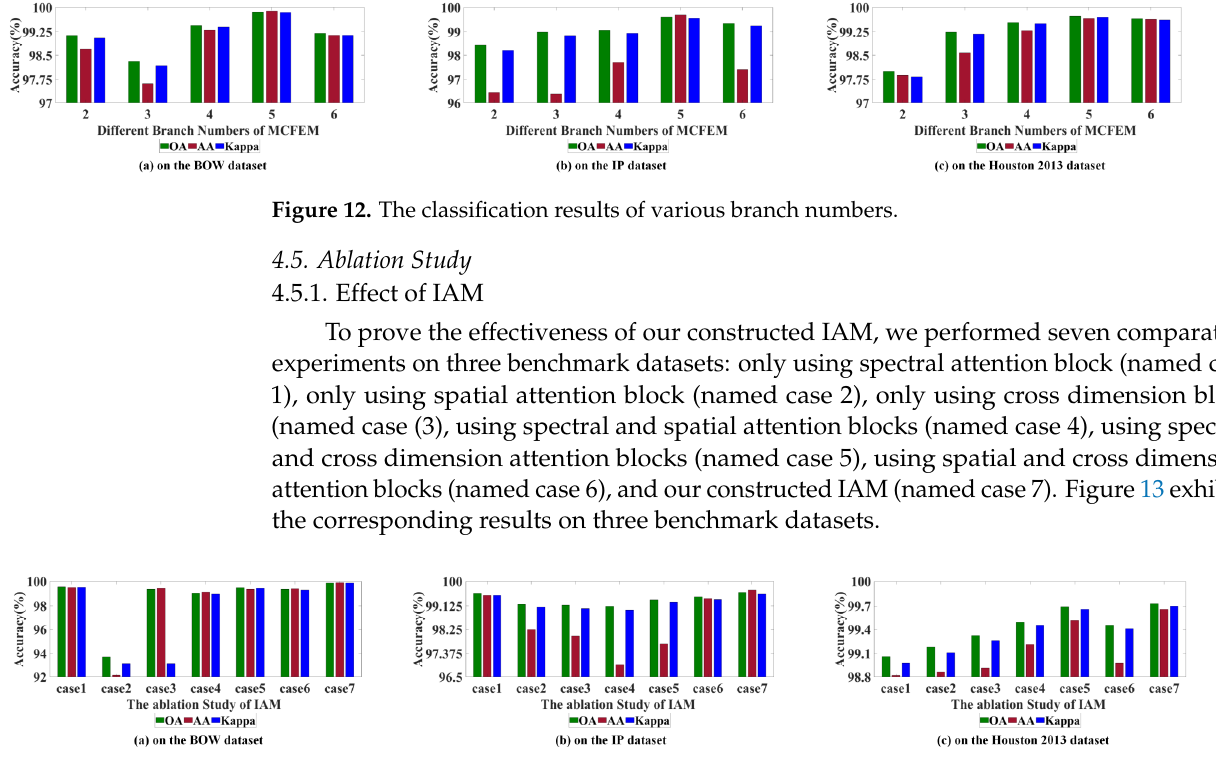
Figure 13. The ablation study of IAM.